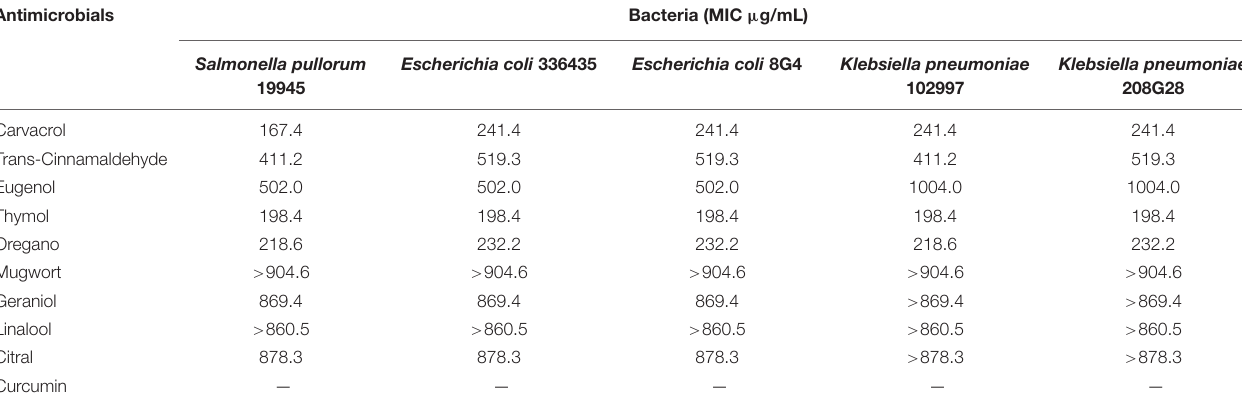
TABLE 1 | Minimum inhibitory concentrations (MIC) values of natural antimicrobials against Poultry-borne pathogens. Antimicrobials